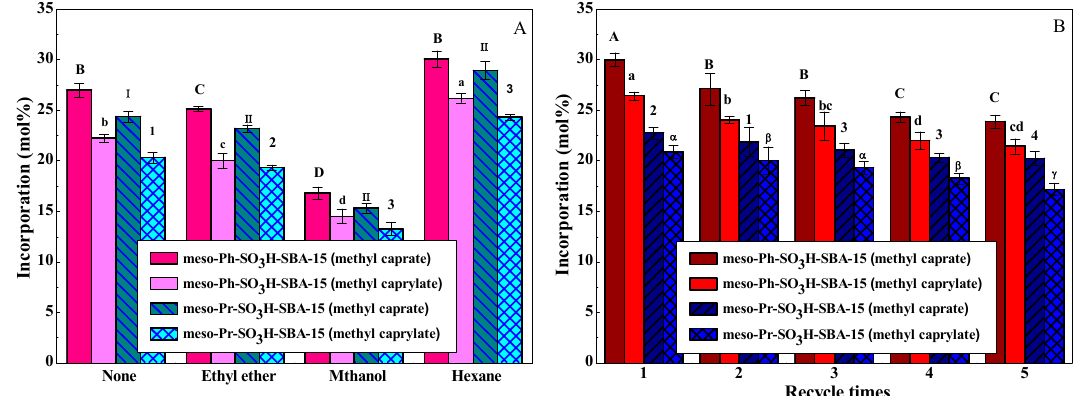
Figure 7. ( A ) Effect of solvent system on SL interesterification over two modified SBA ‐ 15 samples. SL: Figure 7. ( A ) E ff ect of solvent system on SL interesterification over two modified SBA-15 samples.